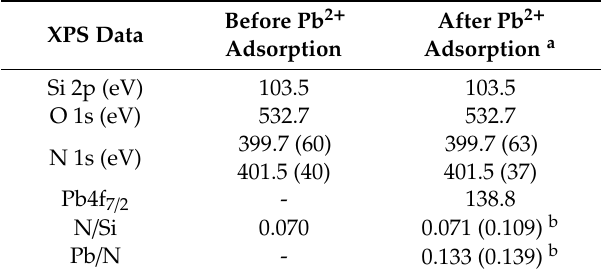
Figure 7. Core level spectra of 3.8N / SBA-16 adsorbate after Pb2 + adsorption: ( a ) N 1s, and ( b ) Pb4f (0.1 g of adsorbent, 20 mL of 200 mg L − 1 aqueous Pb 2 + solution, pH = 5.0, contact time of 60 min, and T = 30 ◦ C). Table 3. Binding energies (eV) of core-electrons and surface atomic ratios of the most optimized 3.8N / SBA-16 adsorbent (from XPS) before and after Pb 2 + ion adsorption.